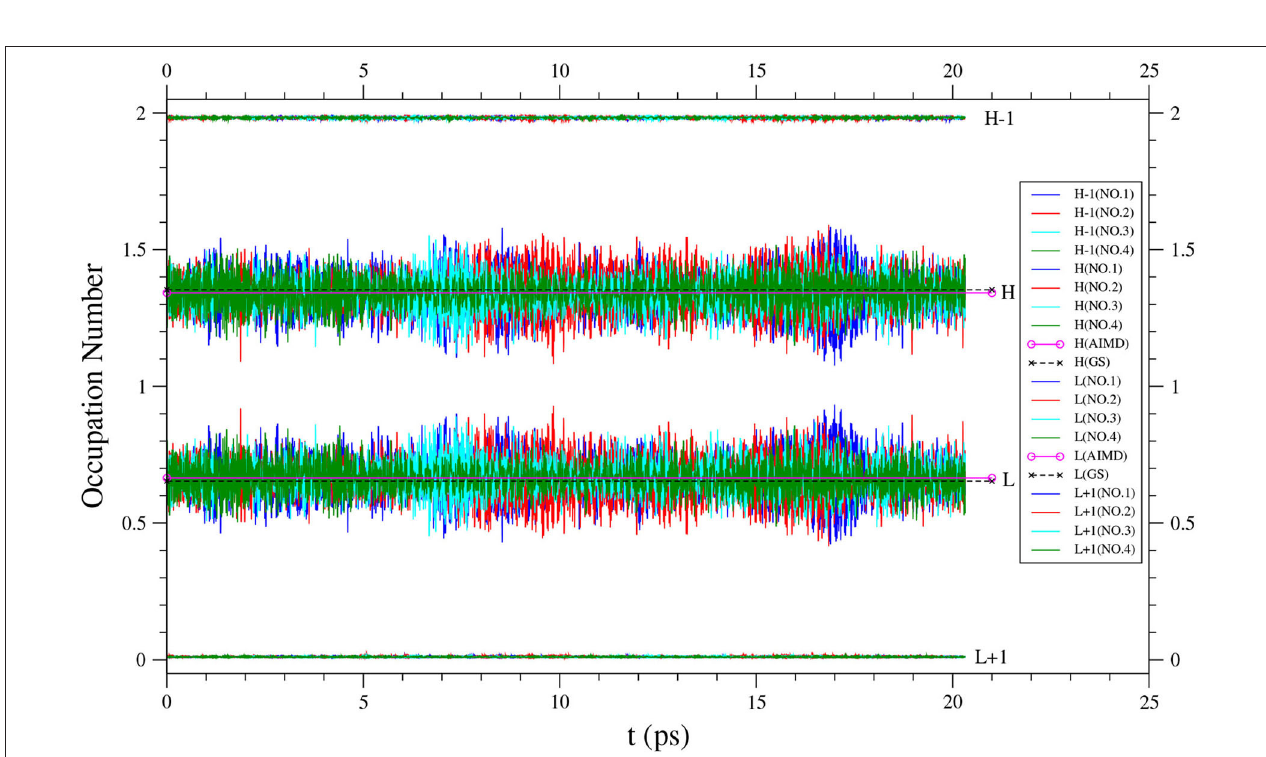
FIGURE 5 | Time evolution of the active orbital occupation numbers (HOMO − 1, HOMO, LUMO, and LUMO+1) of 8-acene, obtained from four different equilibrated TAO-AIMD trajectories (No.1 to No.4) at 300 K, calculated by TAO-LDA. For HOMO/LUMO, the TAO-AIMD average and GS values are also shown for comparison.